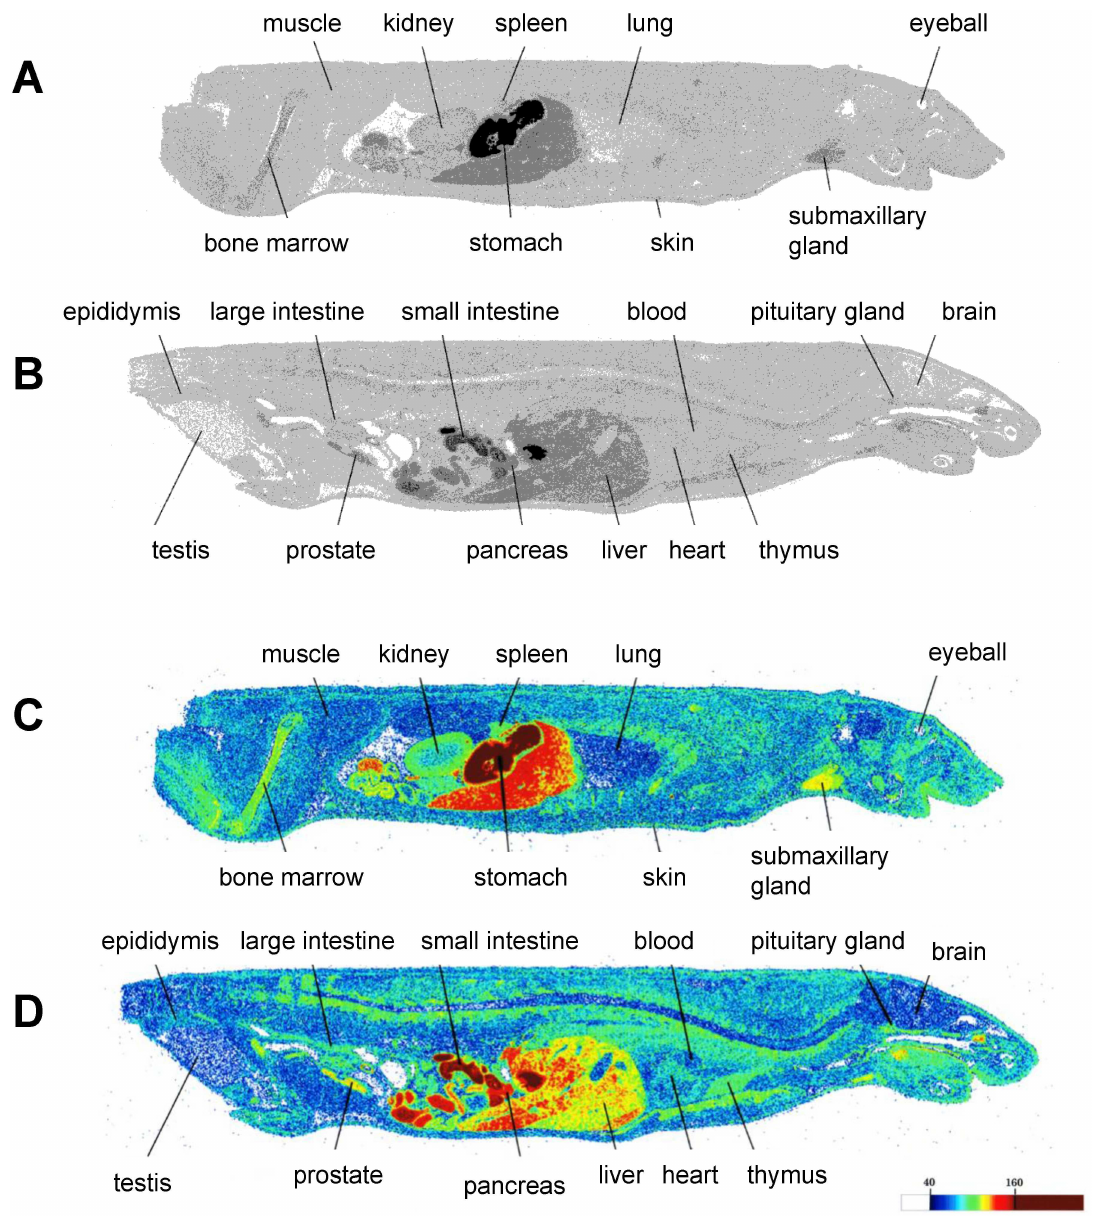
Fig 3. Autoradiographic images of mice after oral administration of MKP labeled with 14 C. Radioactivitydistributionat 15 min after oral administration of 14 C-MKP and CH-3 to male mice. Dorso-ventral section includingkidney ( A , C : colored)and dorso-ventral mesion section ( B , D :